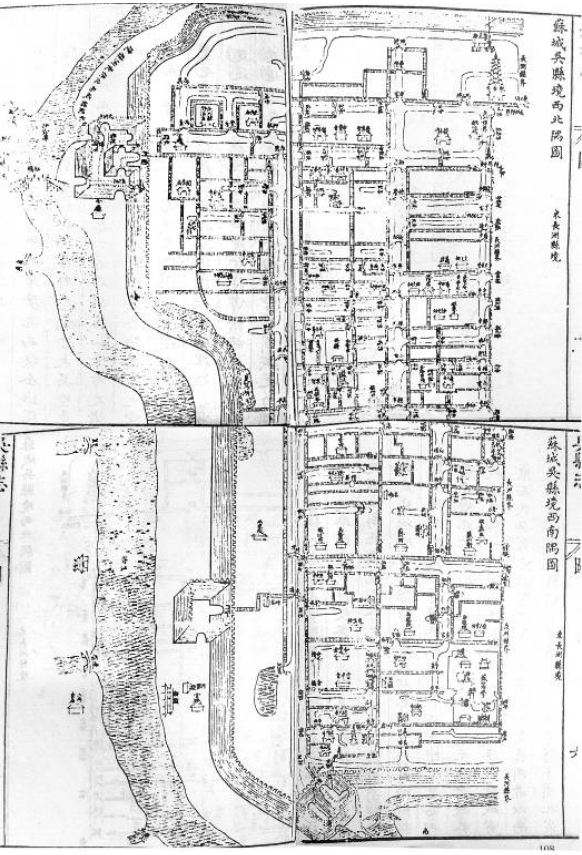
Figure 14. The map of Suzhou from 崇禎呉縣志 Chongzhen Gazetteer of Wu County .